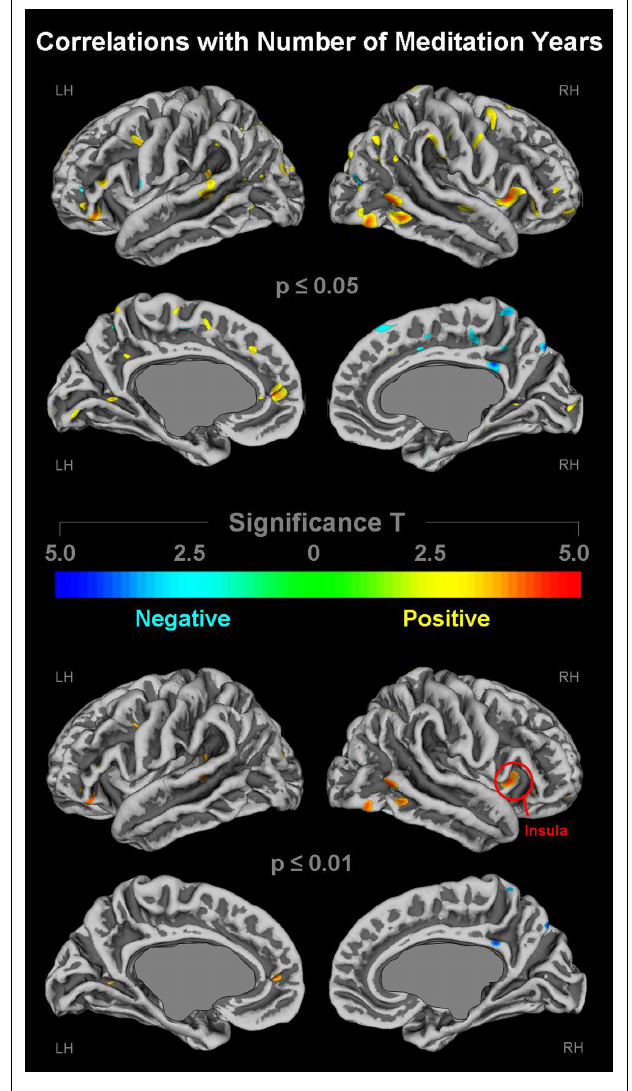
FIGURE 2 | Group differences in cortical gyrification. Shown are group differences at p ≤ 0.05 (upper panel) and p ≤ 0.01 (lower panel), uncorrected for multiple comparisons.The color bar encodes significance ( T ). Areas with larger gyrification in meditators (MED) are depicted in yellow/orange; areas with larger gyrification in controls (CTL) are depicted in cyan. Callosal, subcallosal, and midbrain regions have been excluded on the medial surface maps. Numeric clusters indicate larger gyrification in meditators at p ≤ 0.01 within (1) left precentral gyrus; (2) left insula; (3) right insula; (4) right fusiform gyrus; (5) right cuneus.The red circle indicates the global maximum. LH, left hemisphere; RH, right hemisphere.